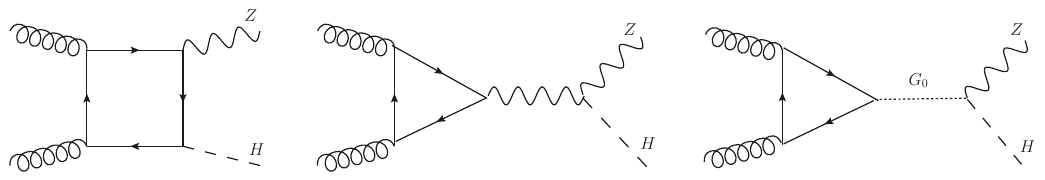
Figure 1 . Diagrams contributing to gg → ZH at leading order. Diagrams related by crossings are not